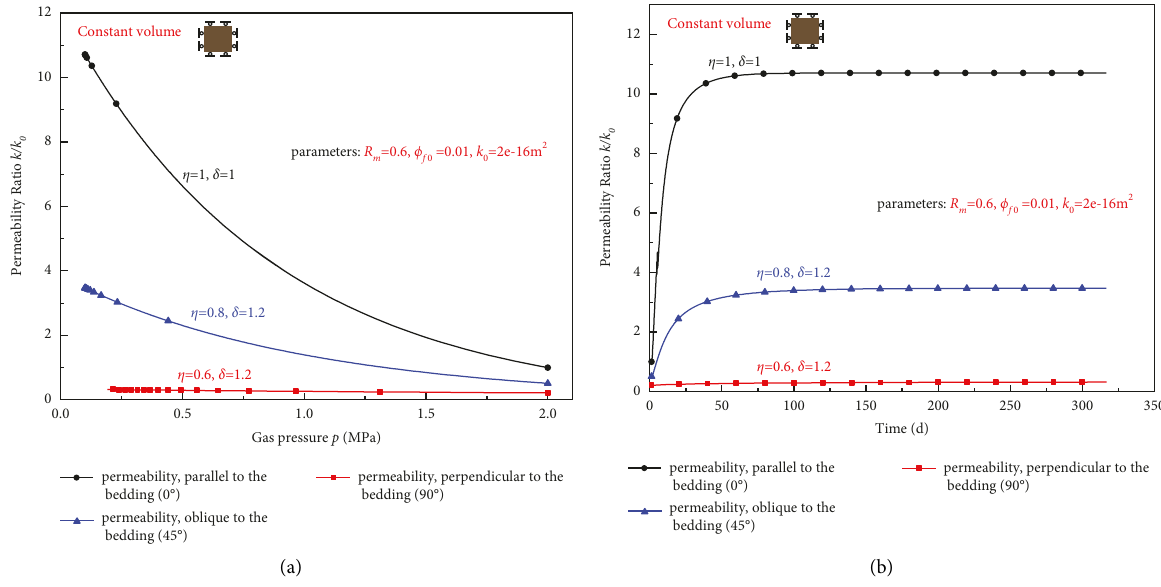
Figure 14: Coal permeability ratio as a function of (a) gas pressure and (b) time under constant volume condition.